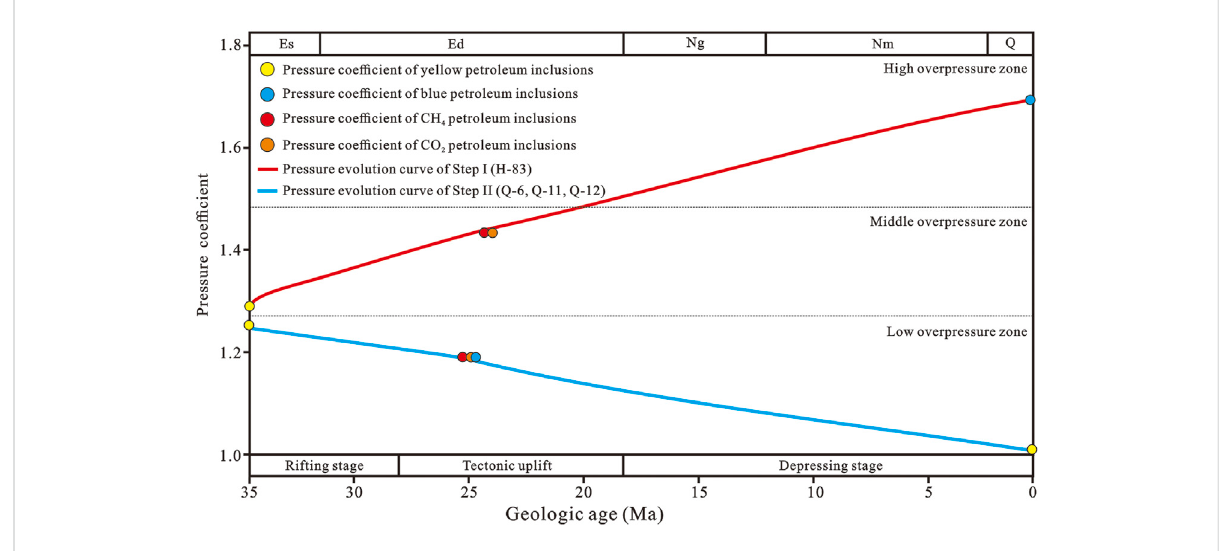
FIGURE 10 Pressure coef fi cient evolutionary process of fl uid inclusions in the Es 3 2 Formation in different tectonic steps of the western slope belt of Dongpu